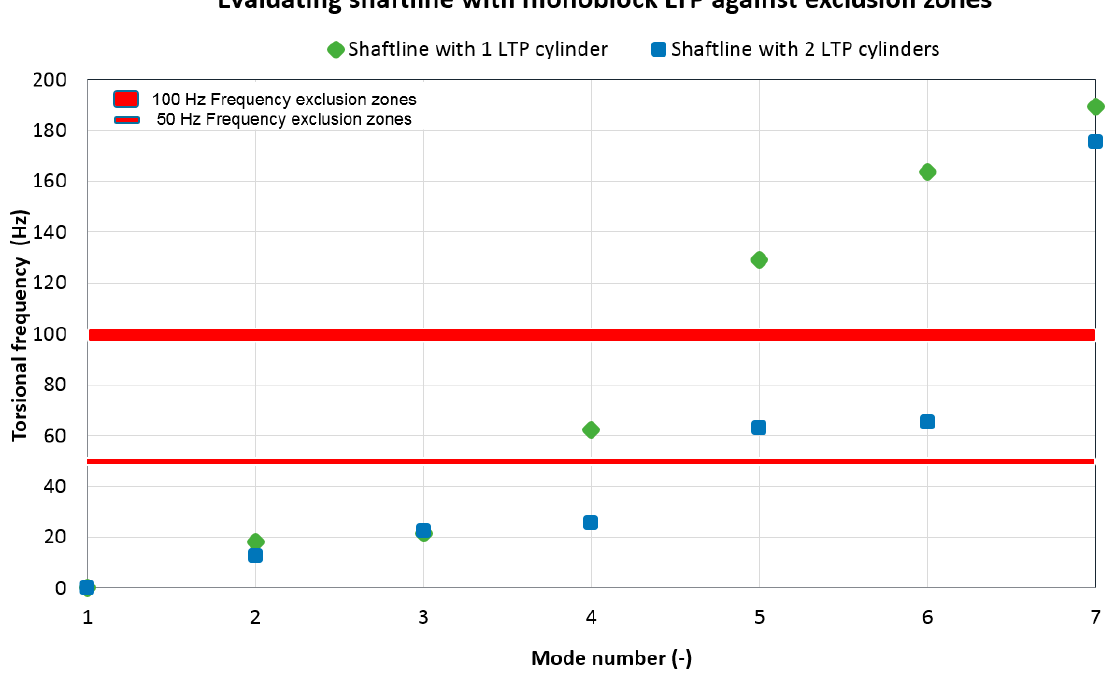
Figure 12. Evaluating welded drum LPT cylinder shaft frequency.